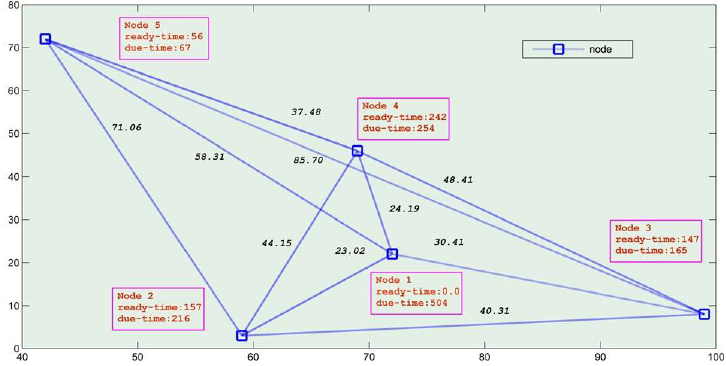
Figure 4. A simple visual example of TSP-TW with 5 nodes